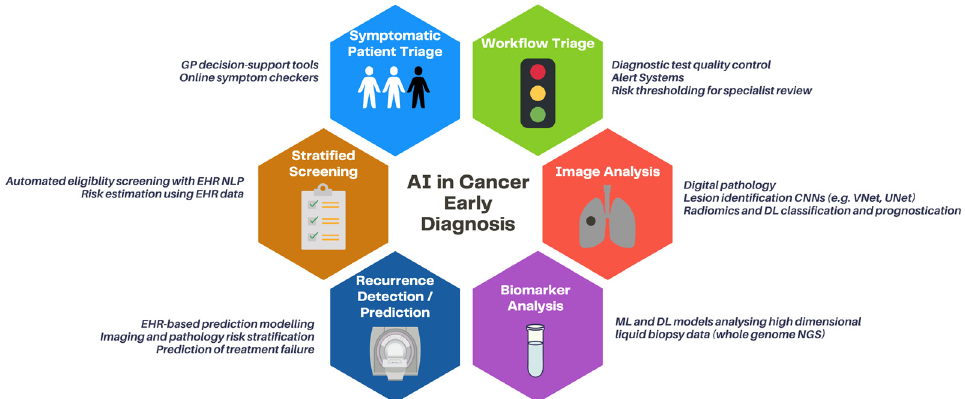
Figure 3. Clinical applications of AI in early cancer diagnosis. Abbreviations: GP: general practi- tioner, NLP: natural language processing, EHR: electronic healthcare record, ML: machine learning, DL: deep learning, NGS: next-generation sequencing.